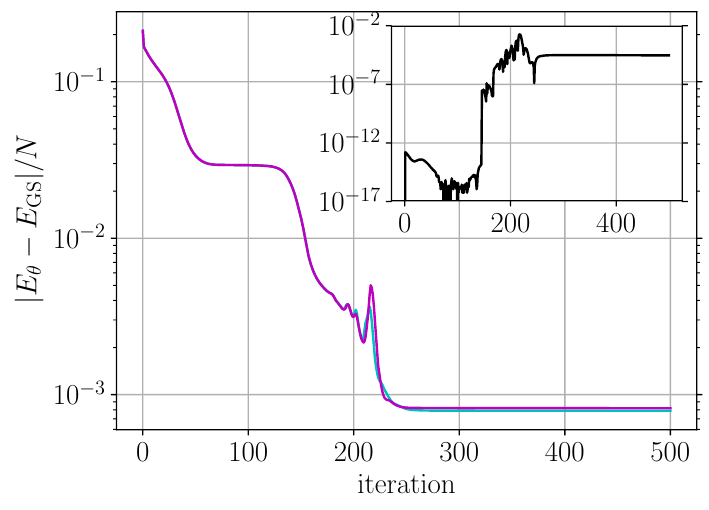
Figure 13: Energy minimization curves in a full-basis simulation. The two simula- tions (cyan, magenta) use two implementations of the VQMC algorithm with the ex- act same neural network initial conditions and hyperparameters. Inset (black curve): the difference between the two energy curves grows with increasing the iteration number. We observe a deviation between the two curves deep down the landscape due to an error multiplication seeded by machine precision and caused by the rugged landscape. We used a shallow holomorphic DNN with six hidden neurons (App. H), / J = 0.5. The system size is N = 4 × 4. Optimization was done using SGD in and J 2 1 combination with SR, see App. A, with a learning rate of γ = 10 − 2